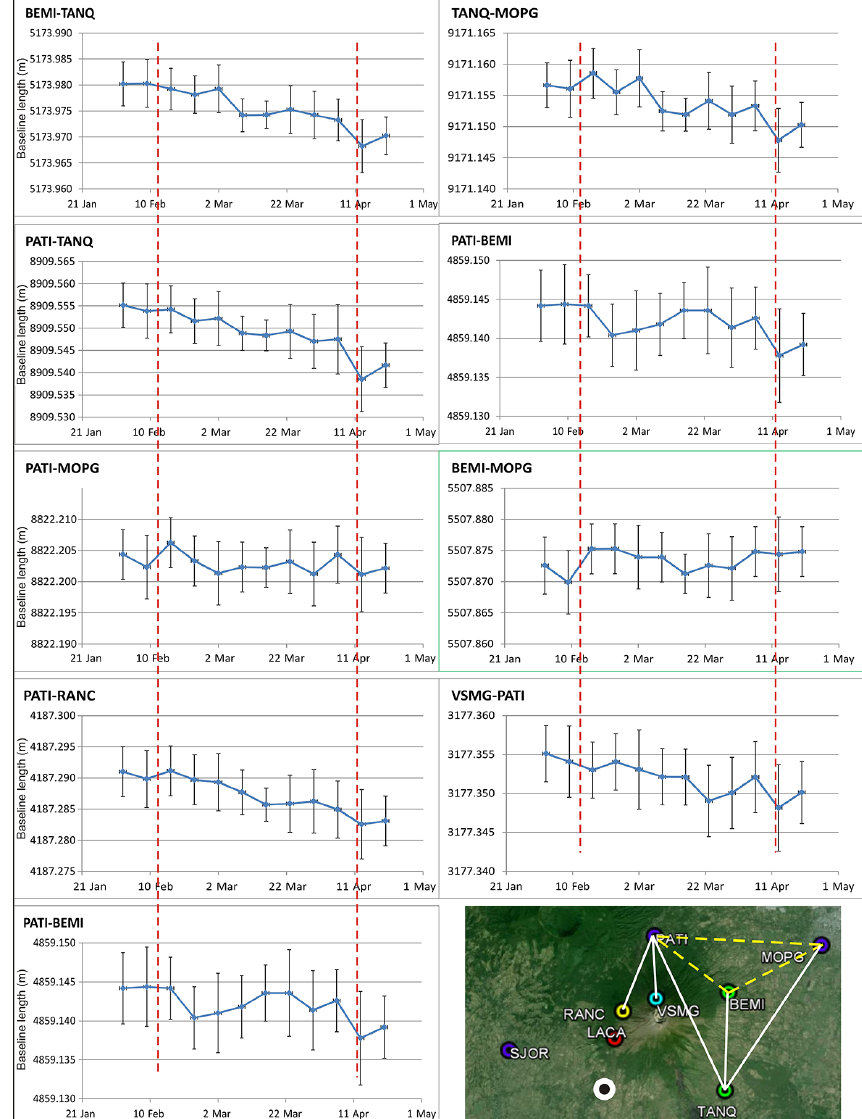
Figure 10. Baseline length variations (meters) between stations lying on the eastern and northern sides of the volcano. The map shows the location and kinematics of the baselines: white solid lines indicate contracting distances, yellow dashed lines indicate the baselines showing no significant